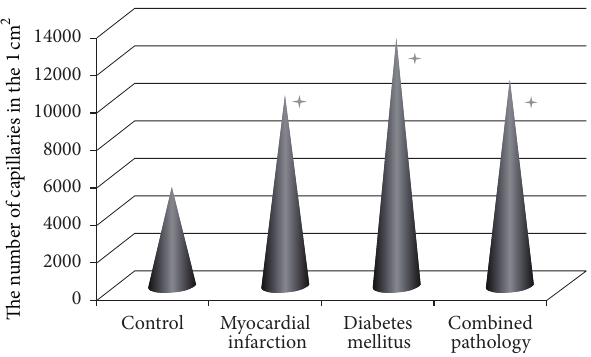
Figure 1: Distribution of capillary density in rat myocardium in case of mono- and combined pathologies. ∗ 𝑃 < 0.01 compared with